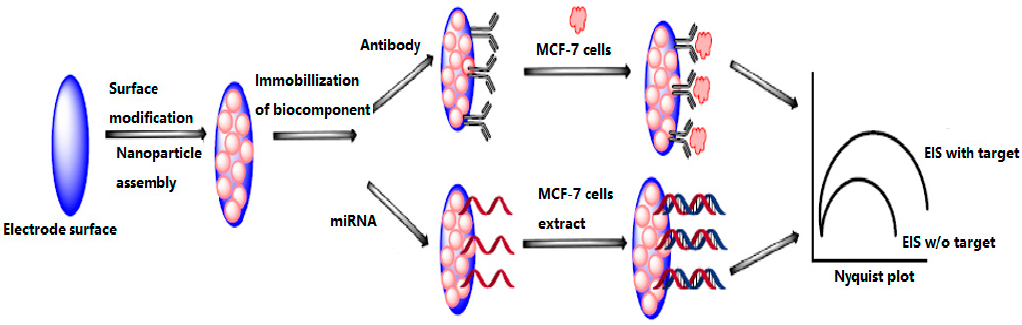
Figure 7. Electrochemical biosensor for detection of MCF-7 cells.